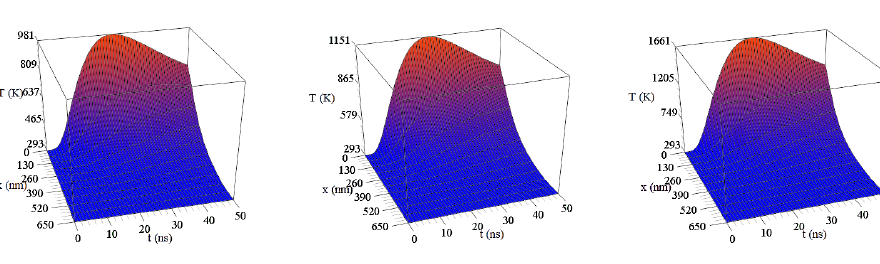
Figure 5. Temperature profile T ( x , t ) for F 0 = 40 mJ / cm 2 .